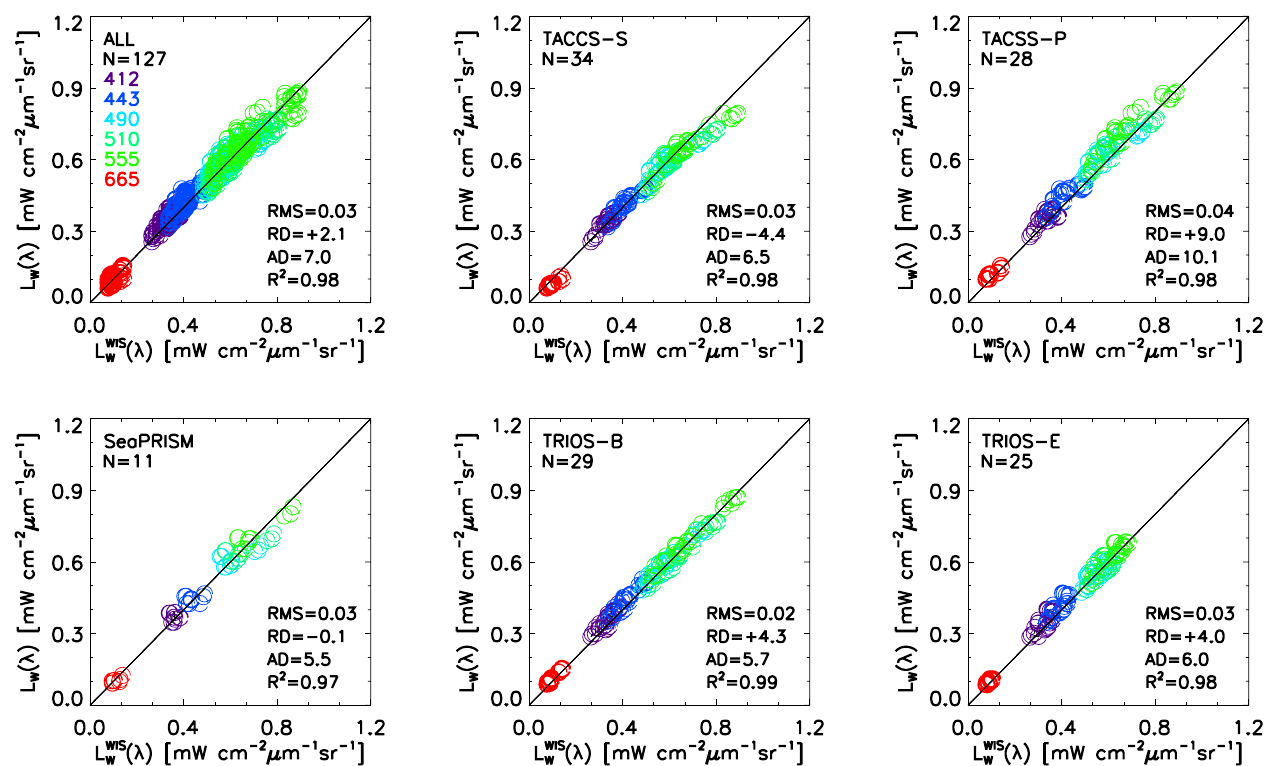
Fig. 2. Scatter plots of L w (λ) from the various systems/methods versus L w (λ) from WiSPER (ALL indicates merged data from all individual inter-comparisons). RMS indicates the spectrally averaged root mean square of relative differences, while RD and AD in % indicate spectrally averaged values of relative differences and of absolute values of relative differences, respectively. N is the number of matchups, all obtained assuming a ± 15min maximum difference between measurements. Diverse colors indicate data at different